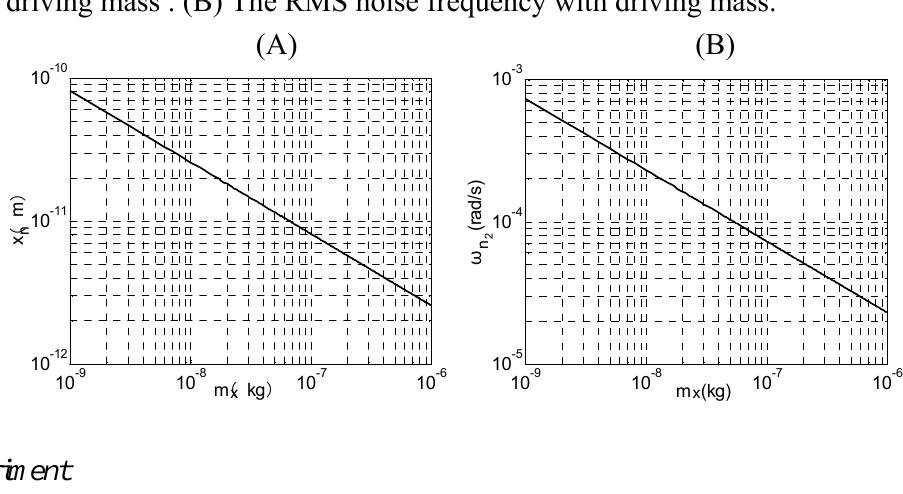
Figure 10. The influence of thermal noise to driving performance when ω =100 Hz, Q =2,500, a = 5 μ m. (A) The RMS noise displacements (rad/s), T=300 K, f B x o with driving mass . (B) The RMS noise frequency with driving